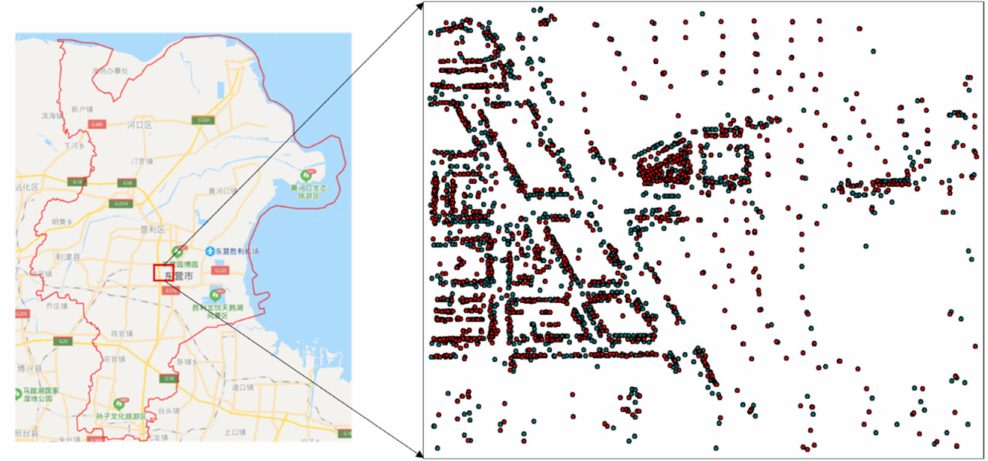
Figure 11. POI matching performance by using the spatial distance.